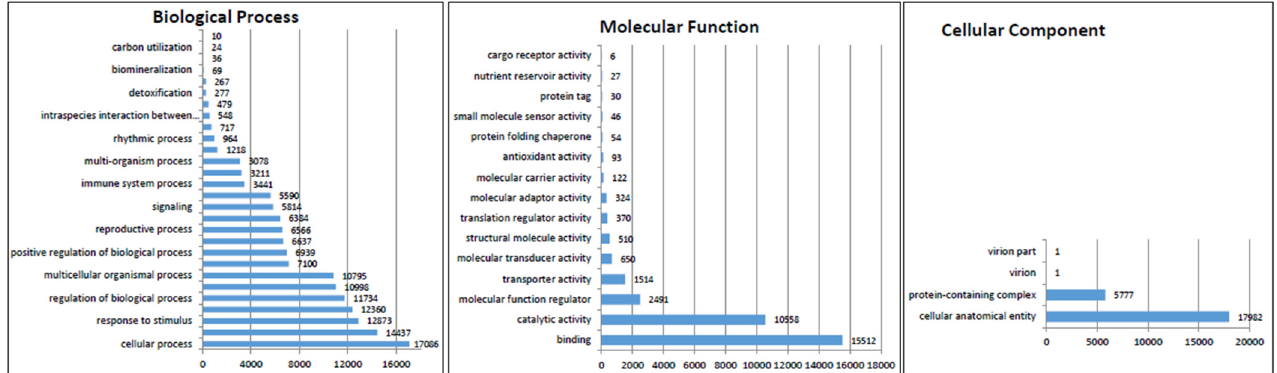
Figure 4. GO analysis of the E. maculata transcripts .